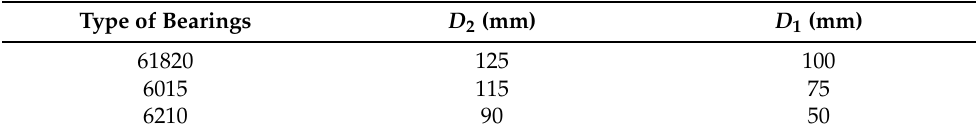
Table 1. List of ball bearings with outer ( D 2 ) and inner ( D 1 ) diameters. Type of